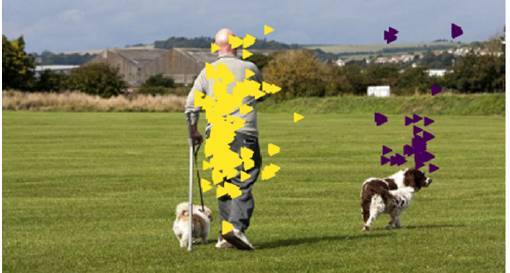
Figure 13. Image No. 1 which denotes the classification results of the clustering method in [10].